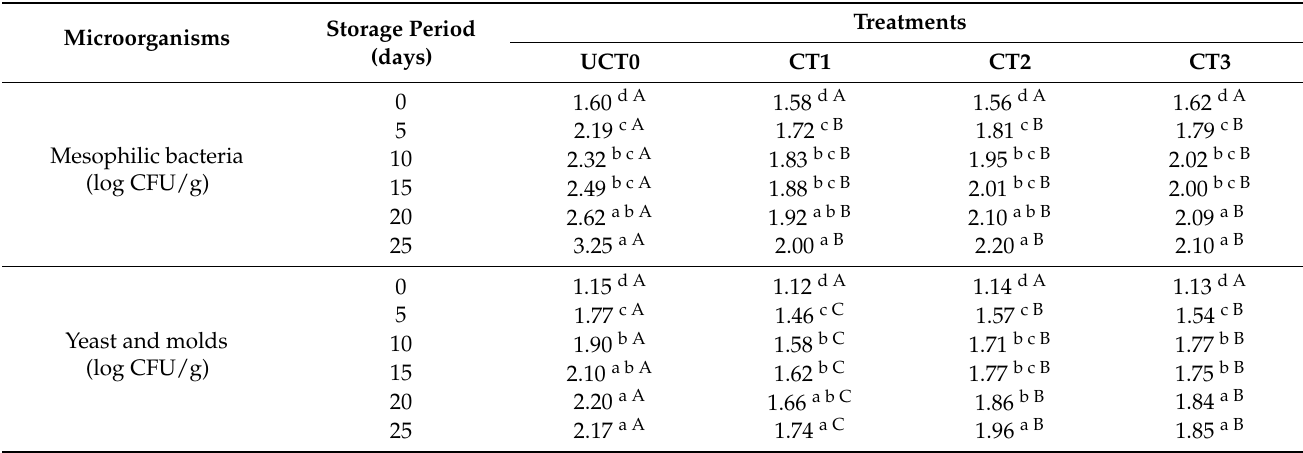
Table 1. Effect of coating on the mesophilic bacteria, yeast, and mold counts in the minimally processed Golden Delicious apple slices stored at 4 ◦ C for 25-days. Microorganisms Storage